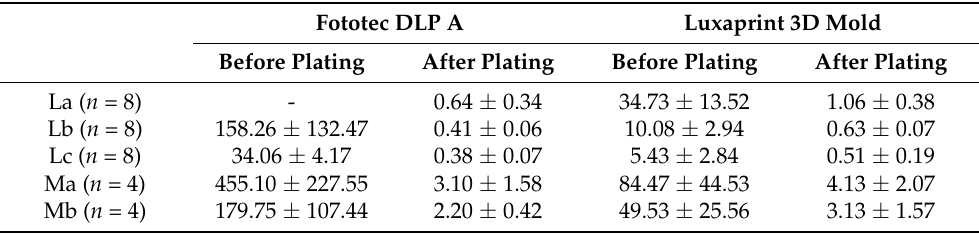
Table 4. Resistance values ( Ω ) before and after 15 min electroless copper plating on printed silver lines (ink: Sicrys I30